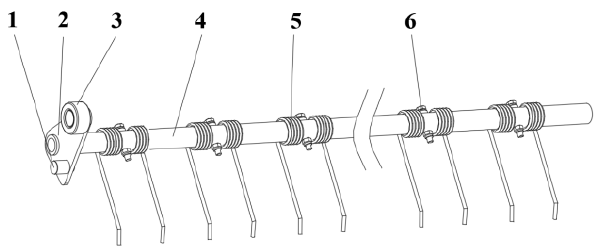
Figure 3. A schematic diagram of the hook and tooth assembly structure: 1. Limit short shaft; 2. Guide side plate; 3. Roller; 4. Hook tooth mounting shaft; 5. Hook tooth; 6. Threaded fastener.